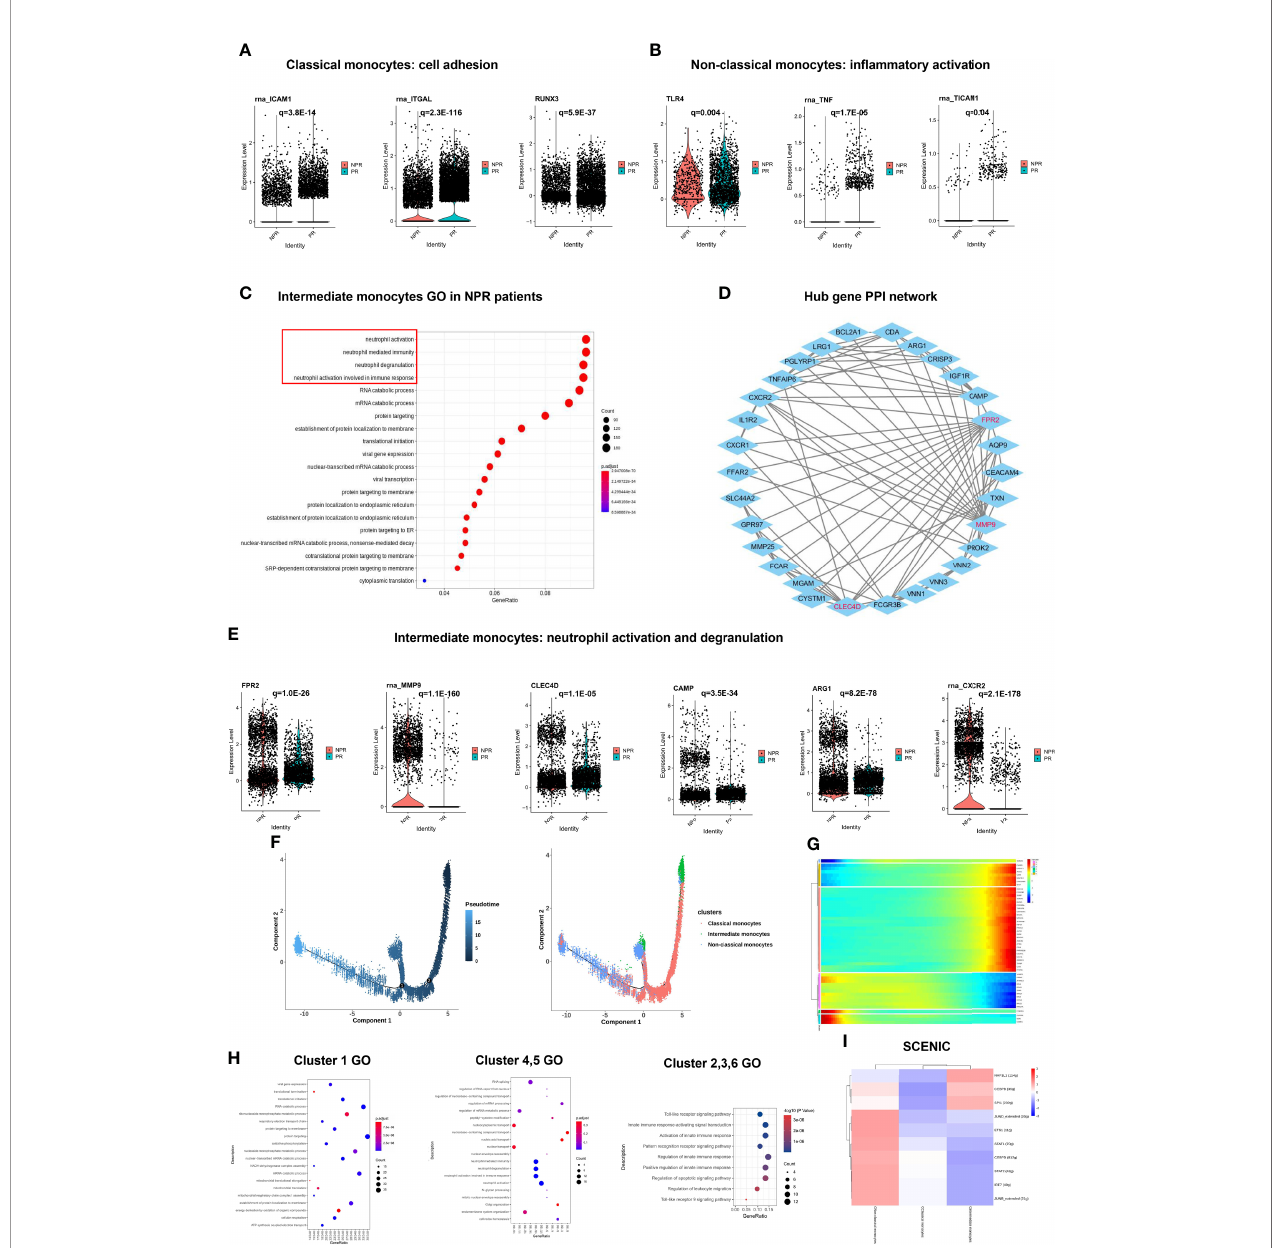
FIGURE 3 | Impact of plaque rupture and without rupture on gene regulation and development trajectory of circulating monocytes. (A) Expression of prototypical leucocyte-endothelial cell adhesion genes such as ICAM1, ITGAL, and RUNX3 were signi fi cant upregulated in classical monocytes of patients with PR. (B) Expression of prototypical pro-in fl ammatory proteins such as TLR4, TNF, and TICAM1 were signi fi cantly expression in non-classical monocytes of patients with PR. (C) GO analysis of upregulated genes in intermediate monocytes derived from patients with NPR. (D) The PPI network of hub upregulated genes in intermediate monocytes in patients with NPR. (E) Signi fi cantly upregulated hub genes associated with neutrophil activation and degranulation in intermediate monocytes derived from patients with NPR. (F) The developmental trajectories of different monocyte subtypes with pseudo-time analysis. (G) Heatmap of signi fi cantly upregulated genes in pseudo-time developmental trajectories. (H) GO analysis of upregulated genes in different clusters in pseudo-time analysis. (I) Heatmap of upstream transcription factors in